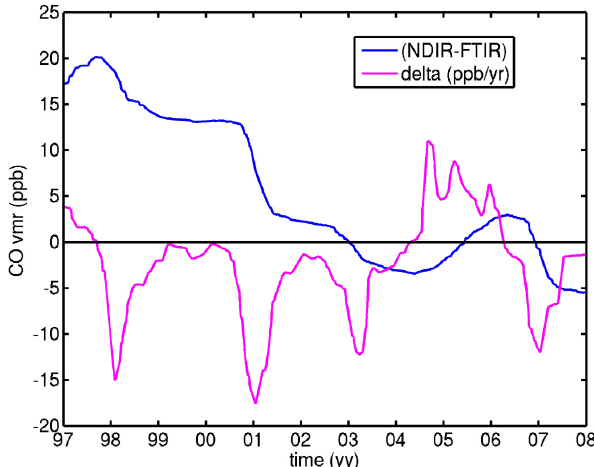
Fig. 6. Time series of NDIR (black and blue curves) and FTIR (red curve) data for CO vmr smoothed with KZ(365,3). For the black curve, all NDIR data were considered; for the blue curve, NDIR data were selected according to a temporal overlap criterium with the FTIR data of ± 2 days.